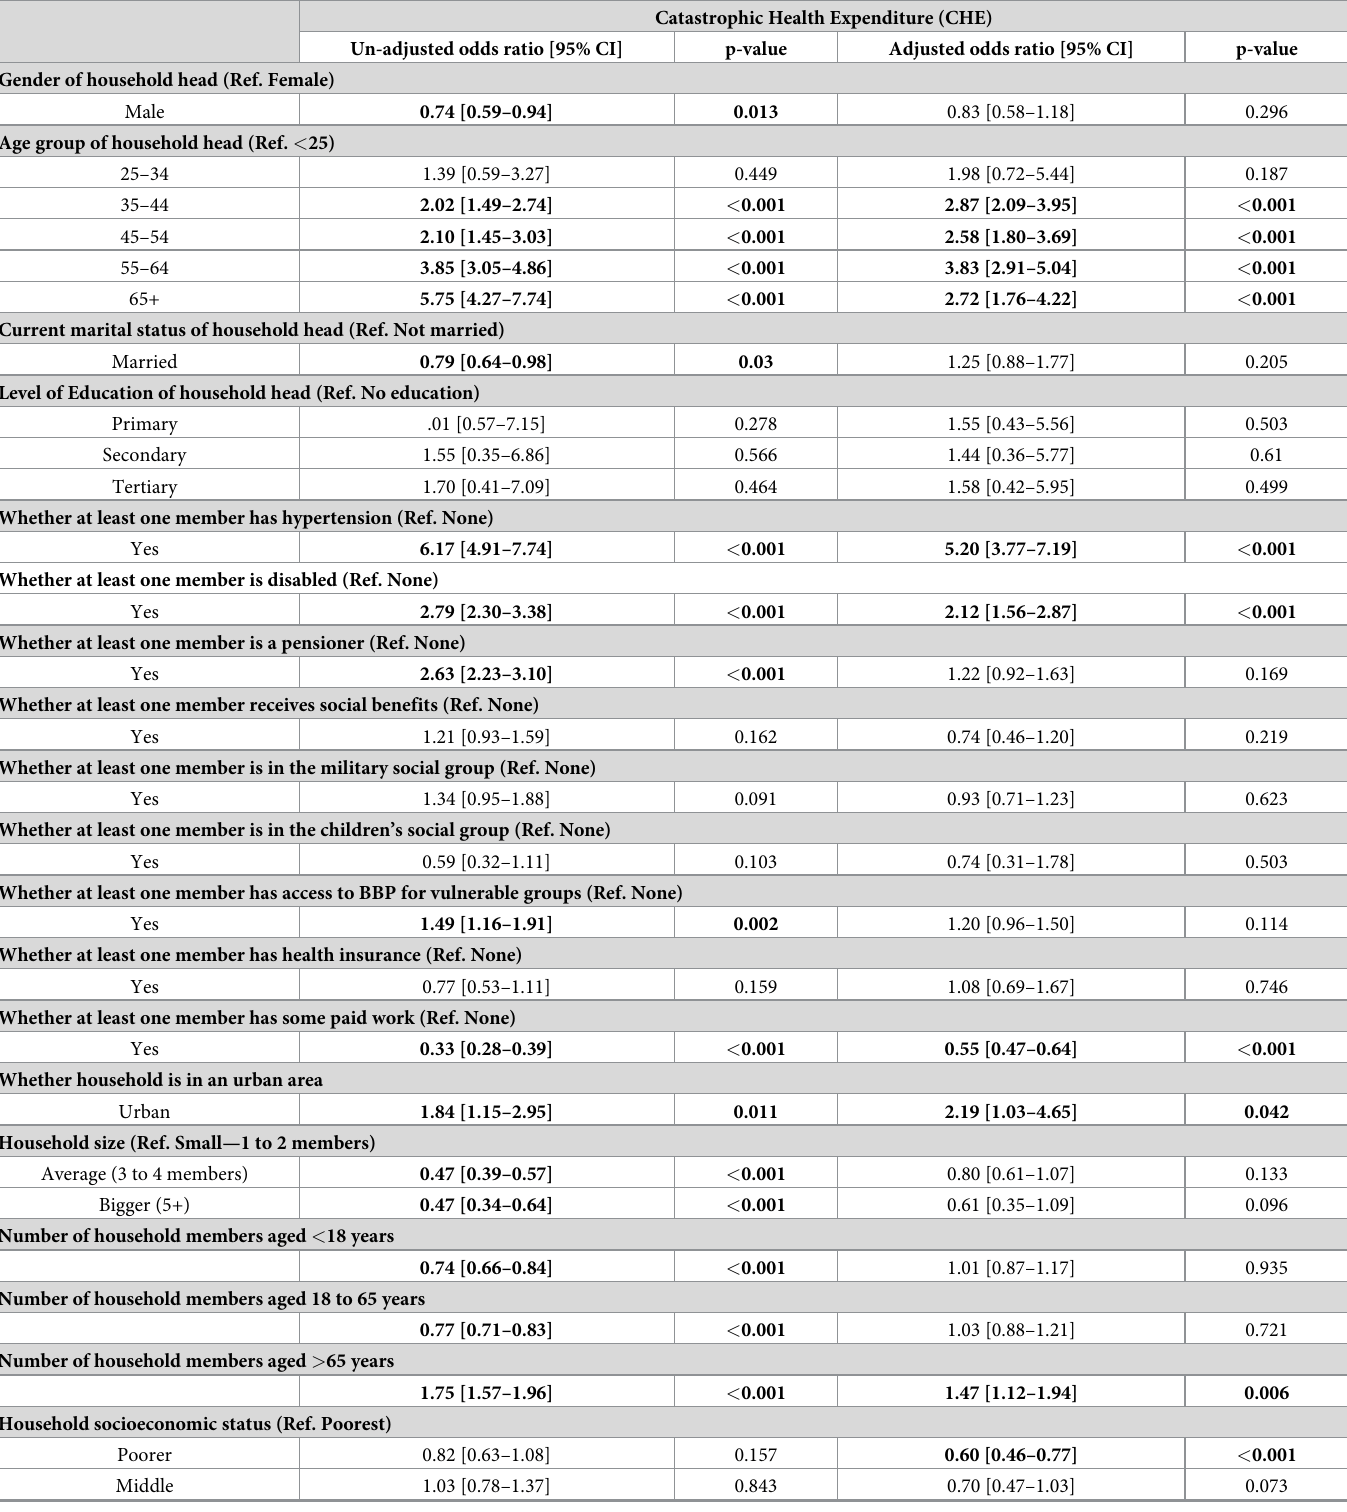
Table 7. Unadjusted and adjusted odds ratio for correlates of CHE.